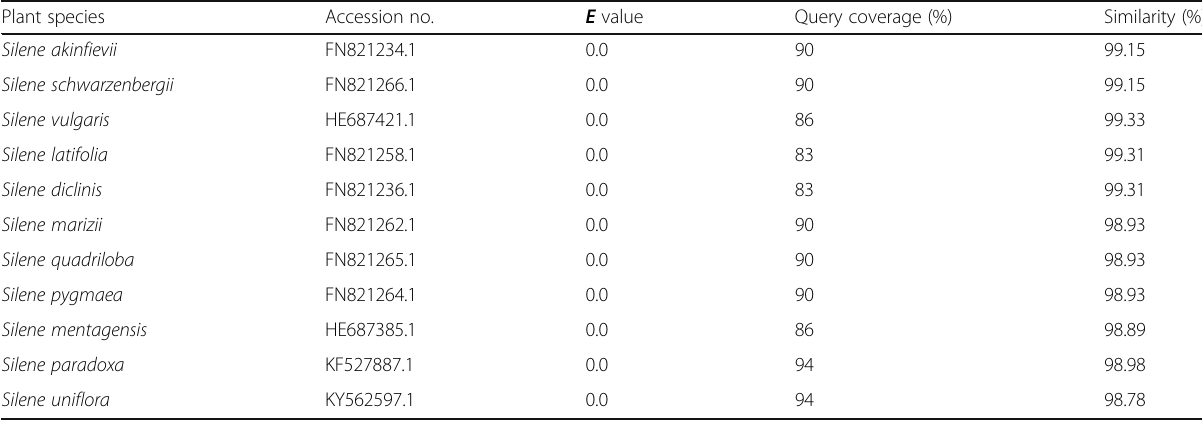
Table 5 DNA barcode of RNA polymerase subunit ( rpoC 1) downloaded from GenBank database including plant species with similarity percentage of more than